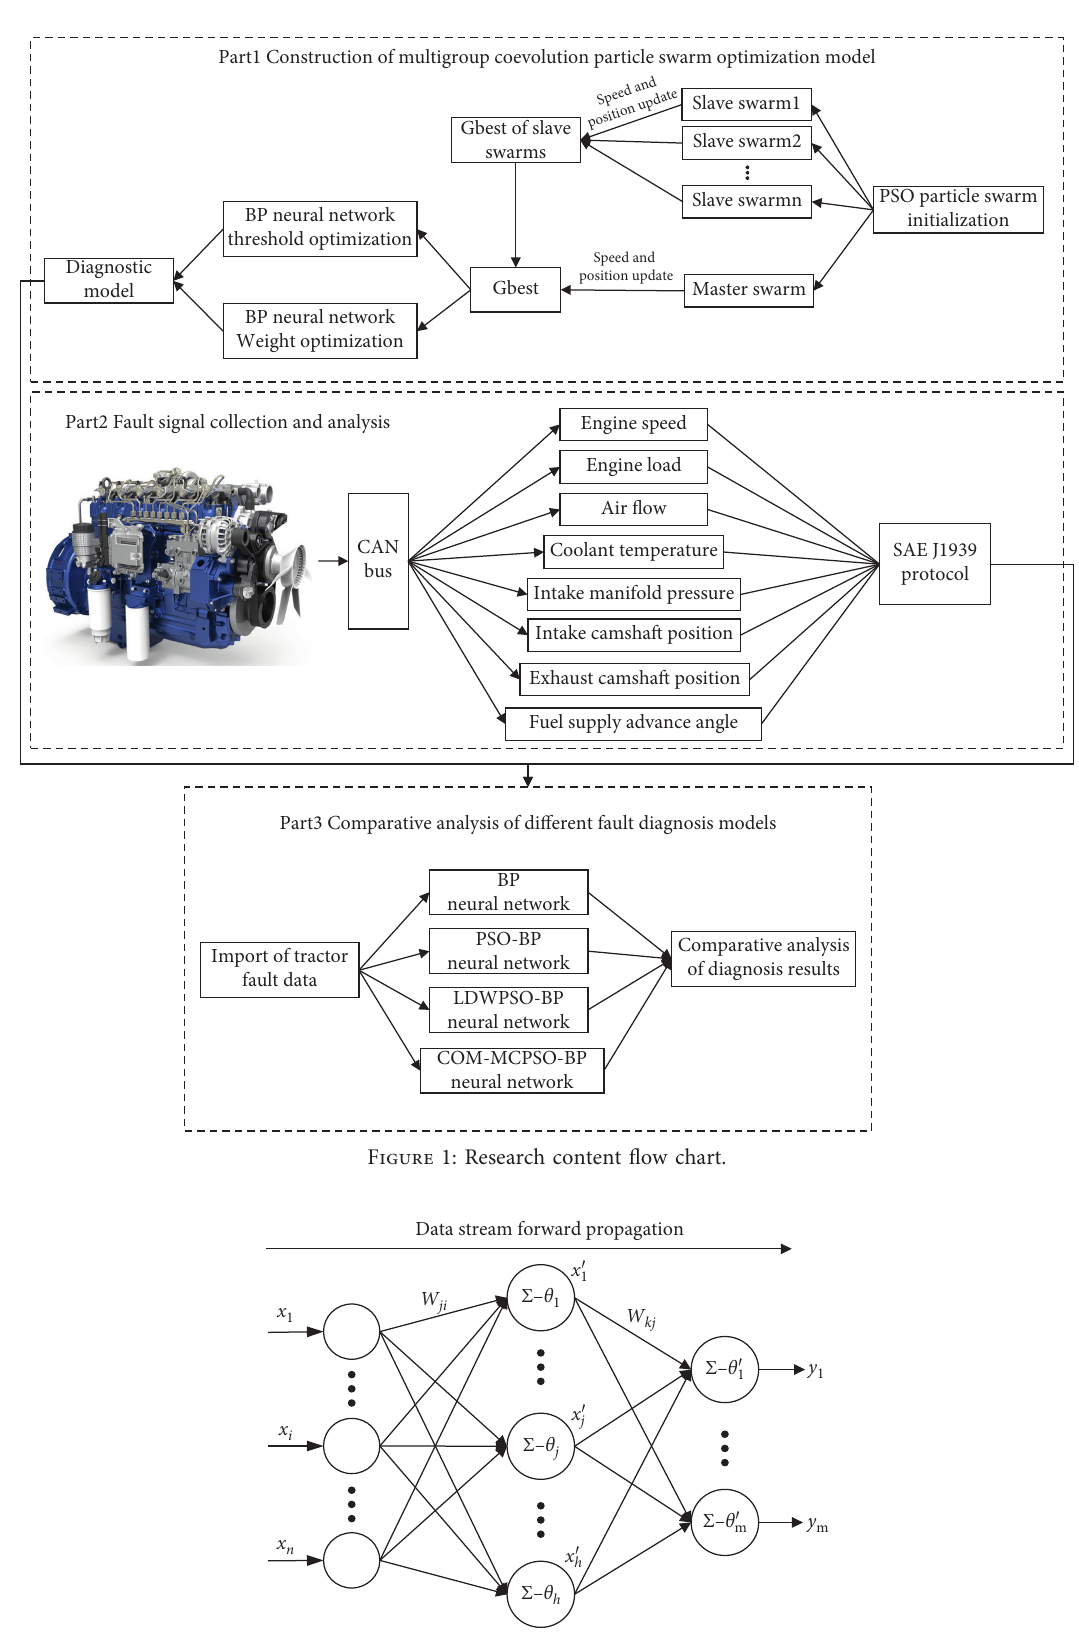
Figure 2: BP neural network